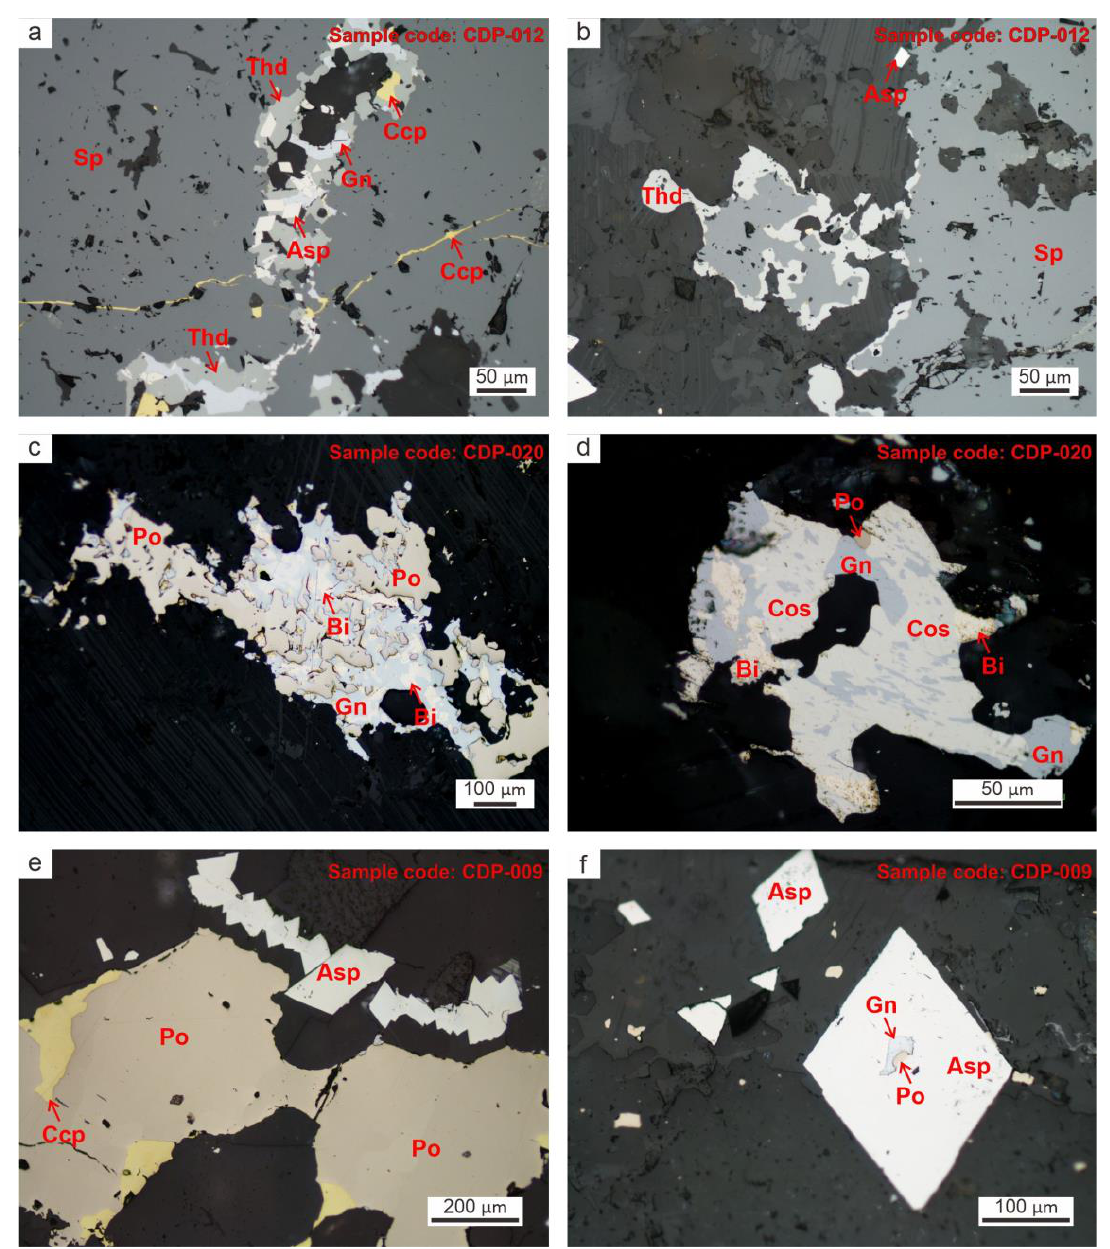
Figure 4. Photomicrographs of Bi-Ag sulfosalts, sulfoarsenides, and their associated ore minerals: ( a ) arsenopyrite and tetrahedrite are found as a filling space between sphalerite; ( b ) sphalerite being rimmed by tetrahedrite; ( c ) native bismuth found as blebby and patchy grains associated with pyrrhotite and galena; ( d ) cossalite–galena with exsolution texture; ( e ) euhedral arsenopyrite grains associated with pyrrhotite and chalcopyrite; ( f ) galena and pyrrhotite inclusions within euhedral arsenopyrite grain. Abbreviation: Sp: sphalerite; Thd: tetrahedrite; Ccp: chalcopyrite; Gn: galena; Asp: arsenopyrite; Po: pyrrhotite; Bi: native bismuth; Cos: cossalite.